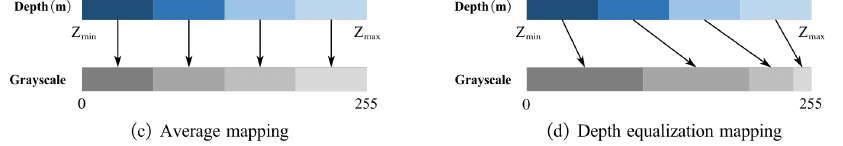
Figure 5. The depth-value distribution of pedestrian objects on two RGB-D datasets ( a , b ) and the two different mapping methods ( c , d